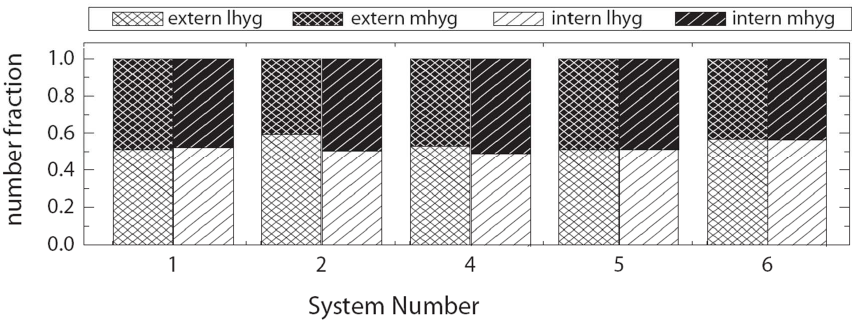
Fig. 7. Externally and internally evaluated mean number fractions of less (lhyg) and more (mhyg) hygroscopic particles of all systems measured at a dry diameter Dp =50nm and at